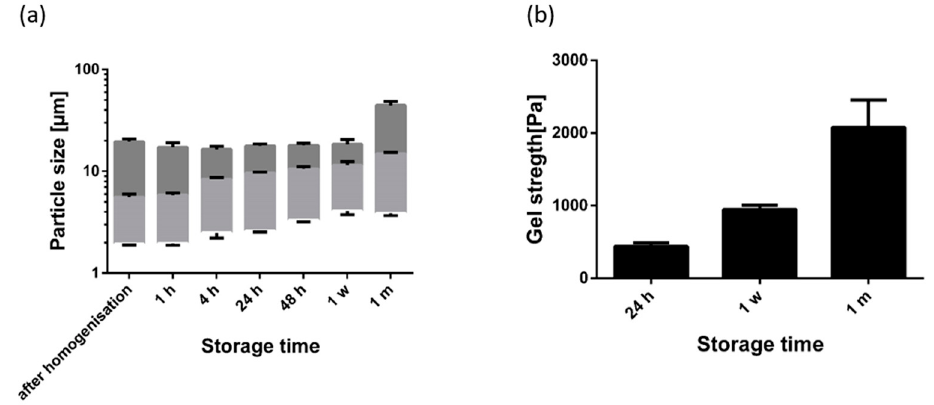
Figure 8. ( a ) Particle size distribution ( × 10 , × 50 , and × 90 values) and ( b ) gel strength of an oleogel (8% TE in paraffin) during one month of storage; mean ± SD, n = 3.